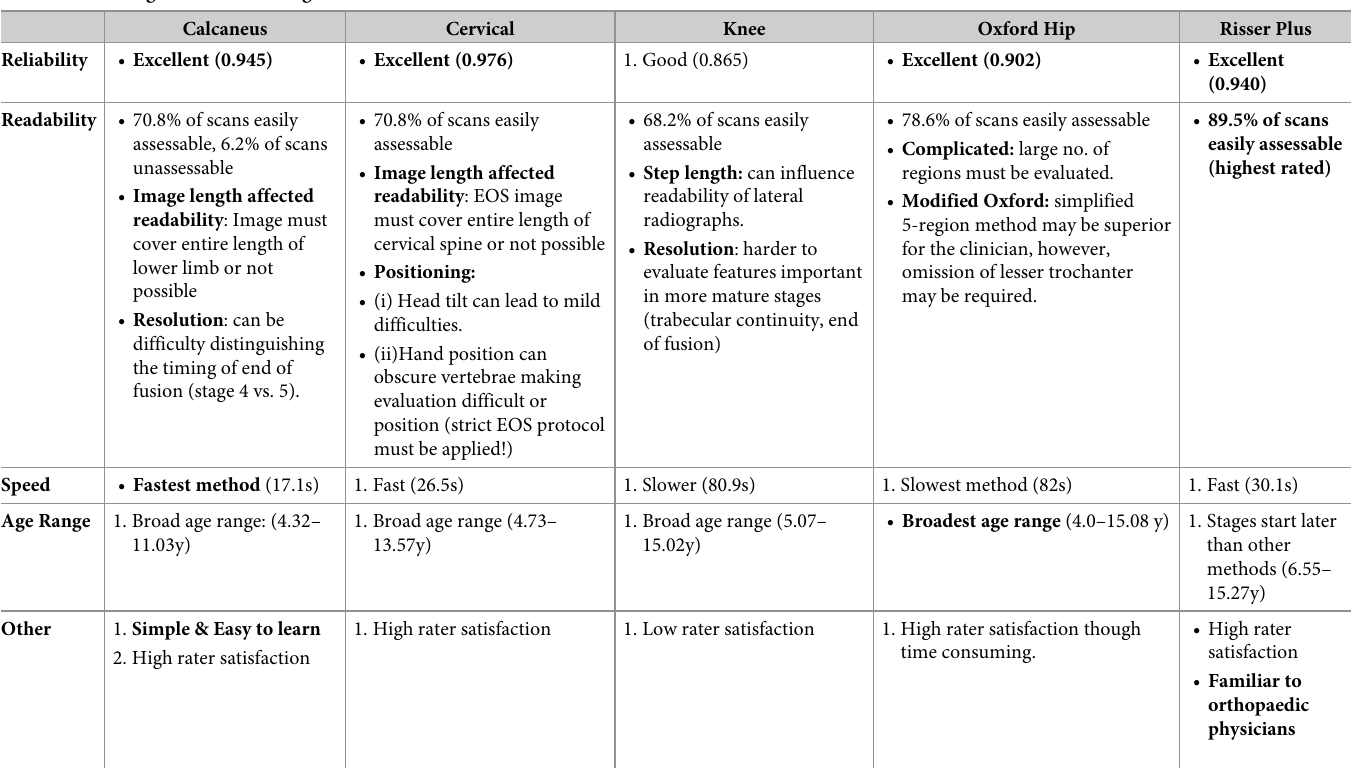
Table 3. Advantages and disadvantages of methods